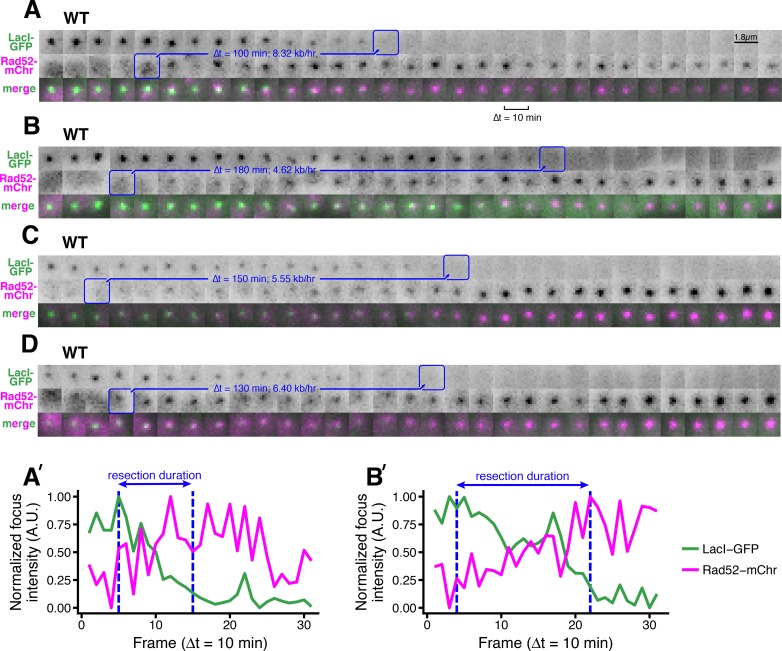
Additional examples of the LacO resection assay in individual WT cells.(A–D) As in Figure 1B, the blue annotations denote the starting point of resection (first frame with a detectable Rad52 focus, which formation shortly after resection begins) and the end point (first frame with total loss of the LacO/LacI-GFP focus) of individual resection events. These start/end frames mark the total duration of resection through the 13.87 kb distance between the HOcs and the distal end of the repetitive LacO array, and are used to compute resection rate (kb/hr) for individual cells. (A’, B’) Additional examples of the subpixel quantification of focus intensity for (A) and (B), respectively, as described in Figure 1D,E and in the Materials and methods.